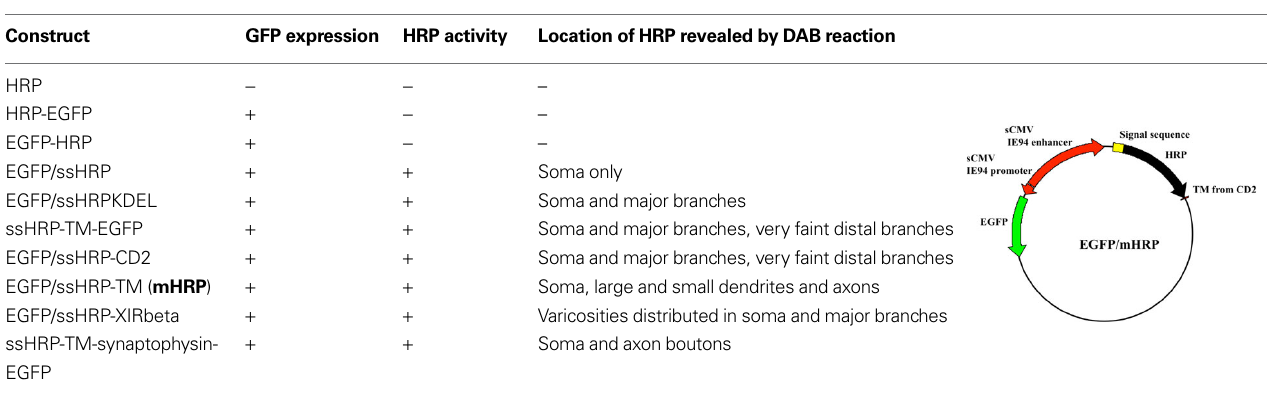
Table 1 | HRP constructs and in vivo